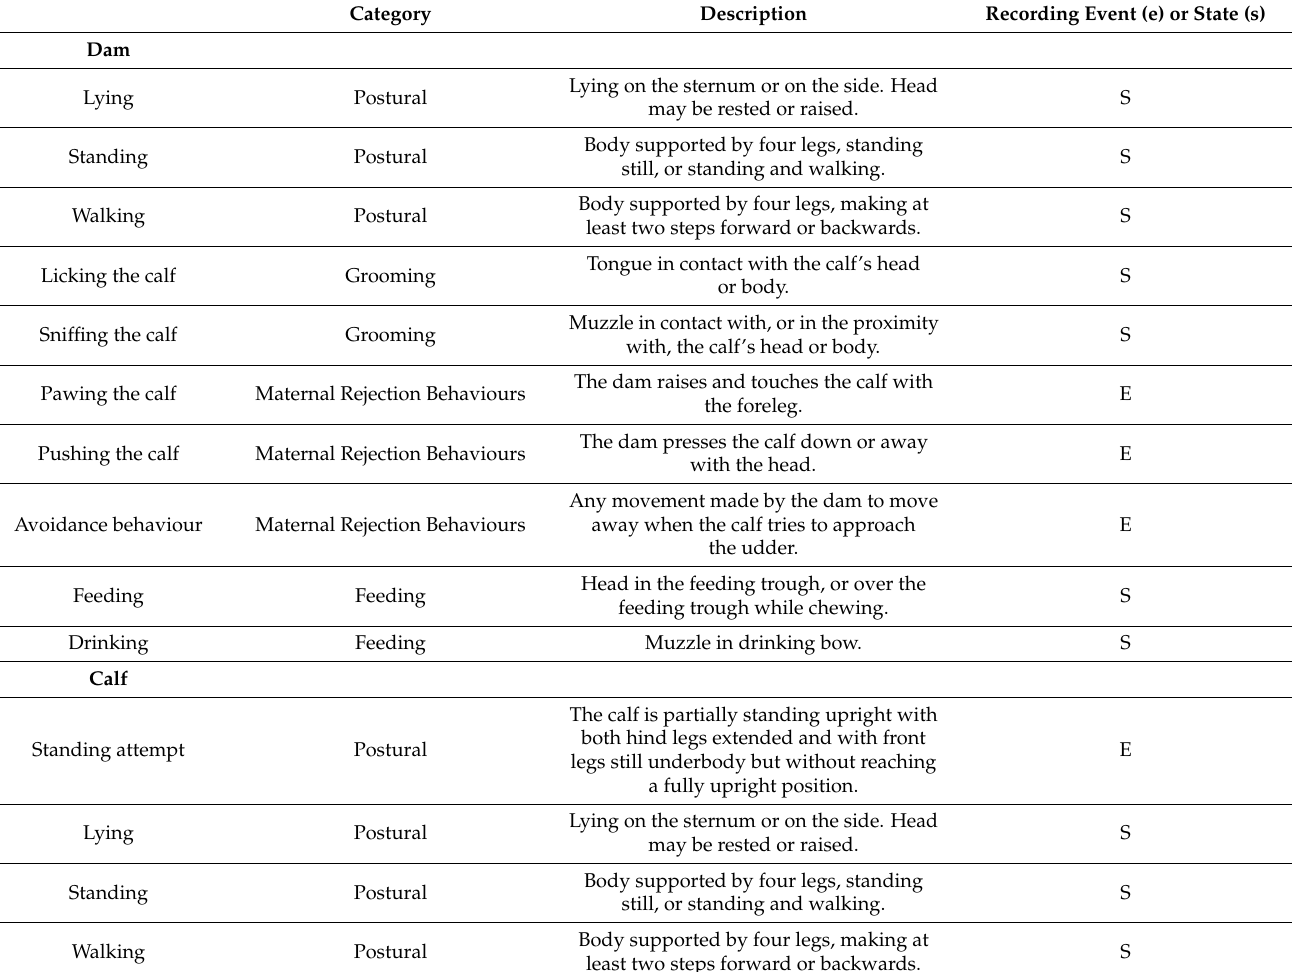
Table 1. Ethogram of the behaviour observed for the dam and the calf. Category